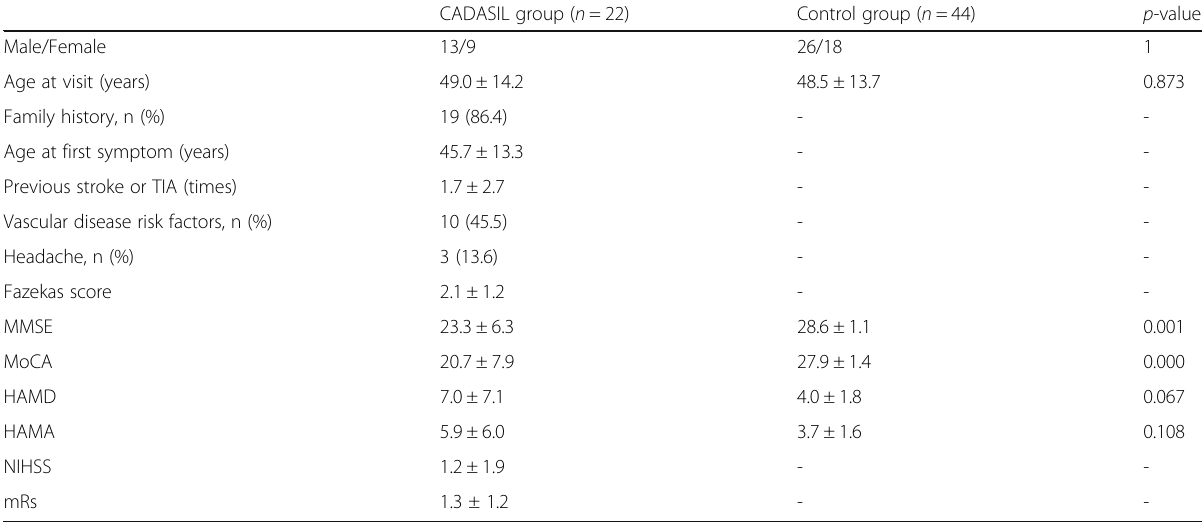
Table 1 Demographic and clinical characteristics of the CADASIL and control groups